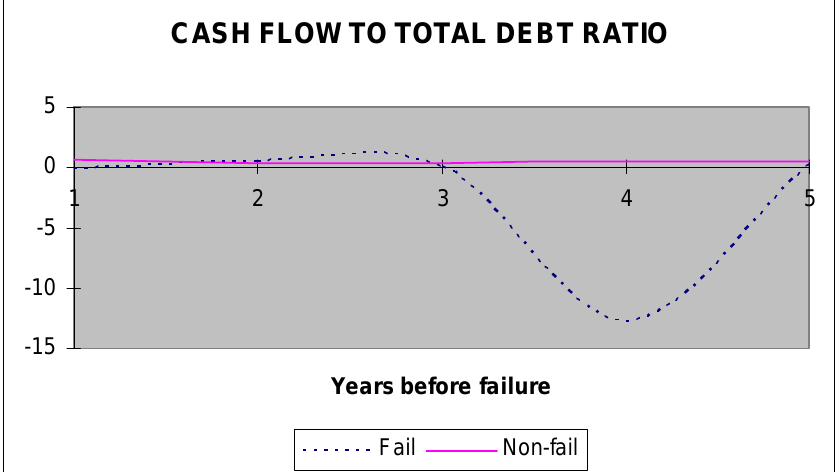
Figure 4: Cash flow to total debt ratio CASH FLOW TO TOTAL DEBT